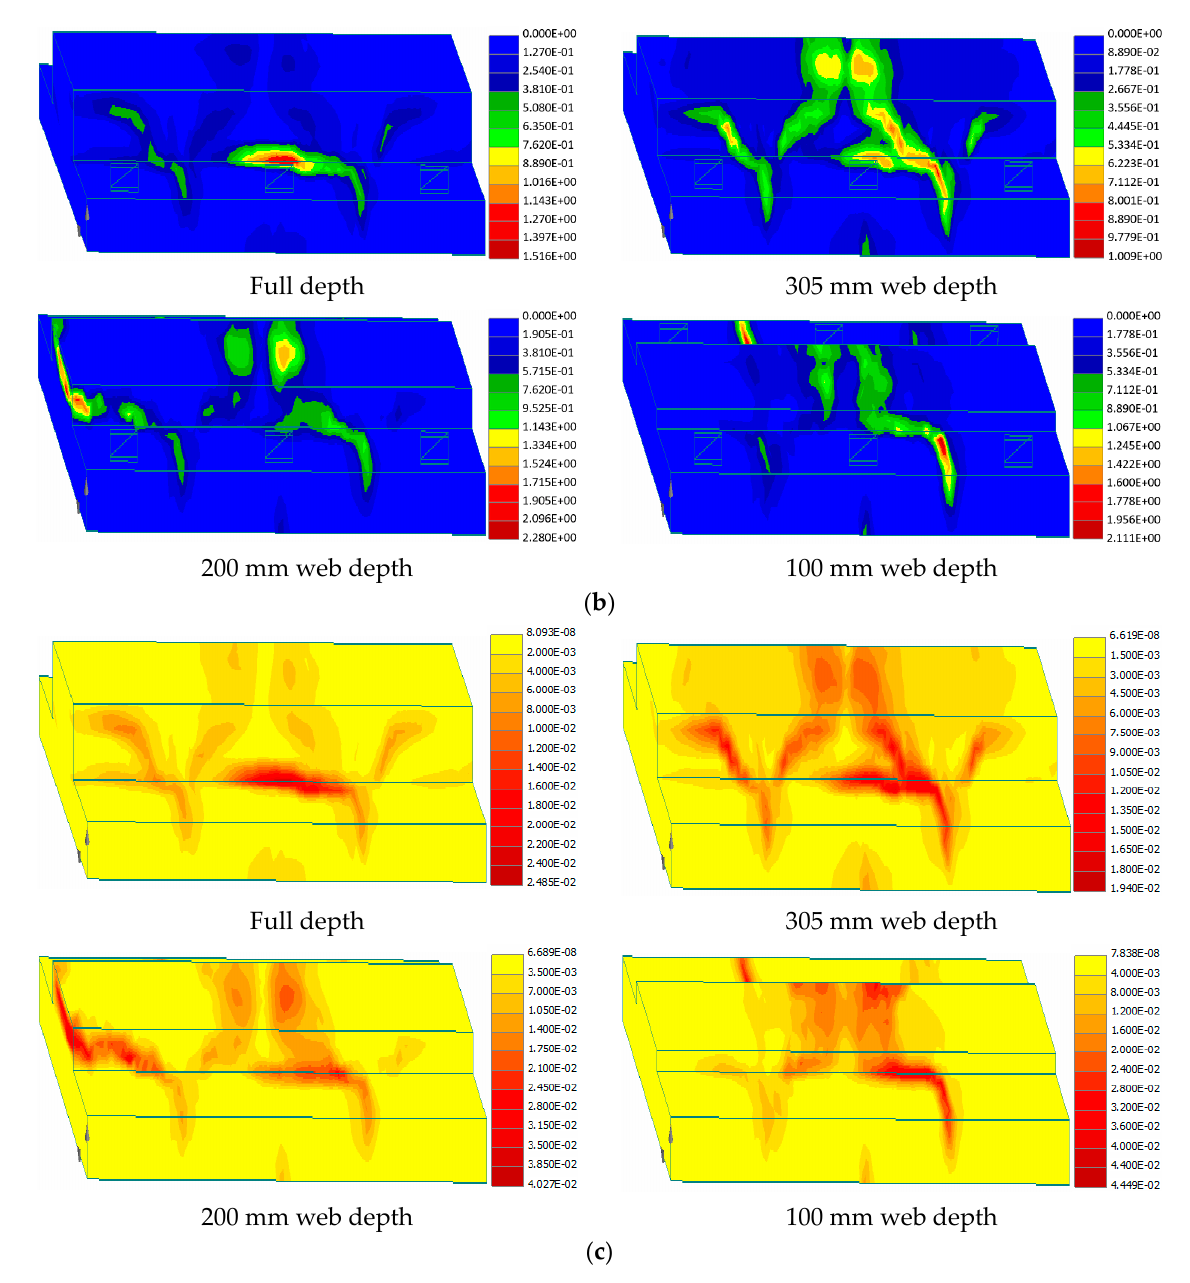
Figure 14. Crack patterns, crack width, and principal tensile strain of 30° skewed beam: ( a ) Crack pattern (30° skew); ( b ) Crack width (30° skew); ( c ) Principal tensile strain (30° skew).